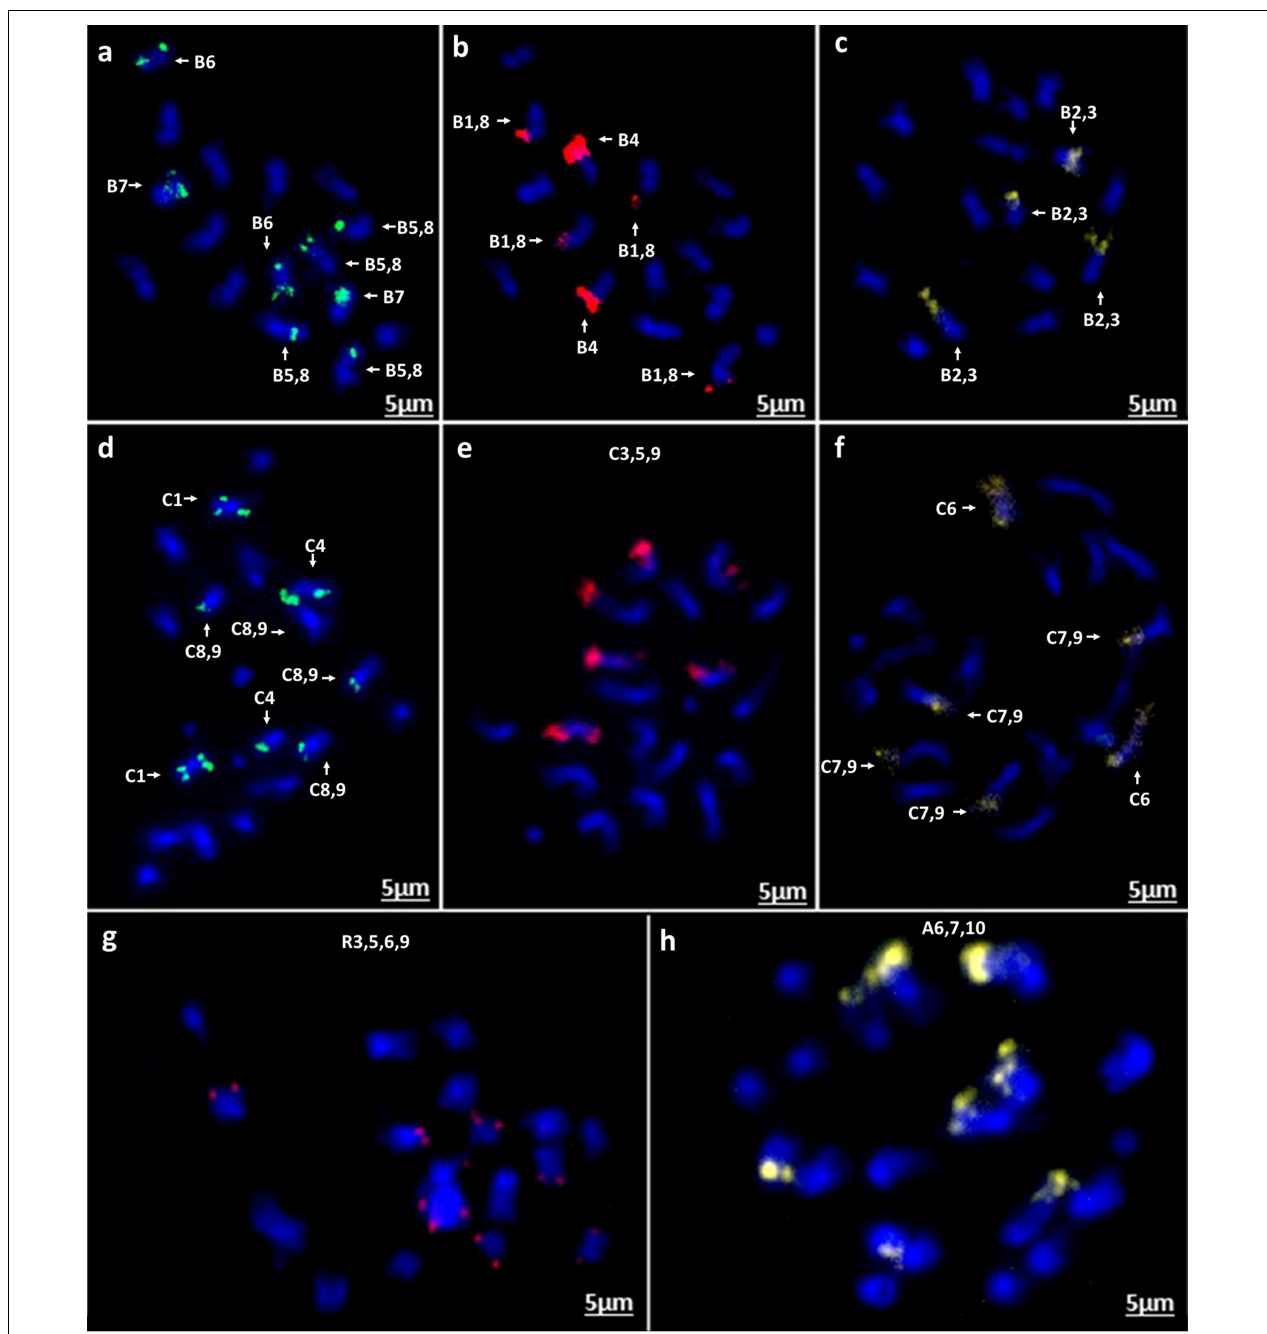
FIGURE 8 | In situ hybridization on mitotic chromosome spreads of B. nigra using four oligonucleotide libraries as Figure 7 . (a) green-Atto488, (b) red-Atto550, (c) yellow-Atto594; B. oleracea (d) green-Atto488, (e) red-Atto550 (f) yellow-Atto594; R. sativus (g) red-Atto550; (h) B. rapa (cv. Turnip Purple Top Milan) yellow-Atto594 demonstrating presence of an intraspecific chromosomal translocation compared to B. rapa cv. Chiffu-401 ( Figure 7c